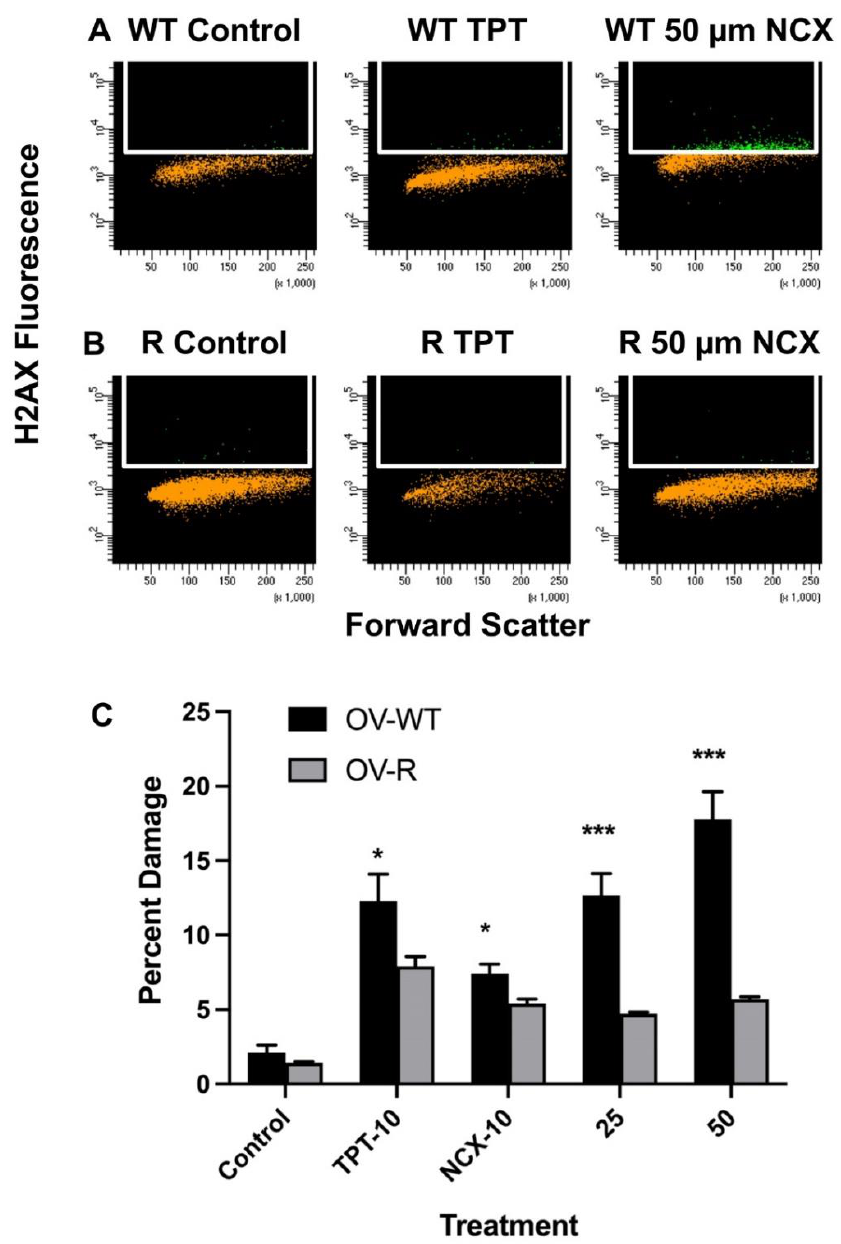
Figure 5. Detection of DNA-double strand breaks produced following treatment with different concentrations of NCX4040 in OVCAR-8 and NCI/ADR-RES cells for 60 min and with different concentrations ( C ). TPT (10 µM) was used as a control. Representative plots ( A , B ) are shown here. * and *** p -values, <0.05, and <0.001, respectively, compared to concentration-matched treatment.